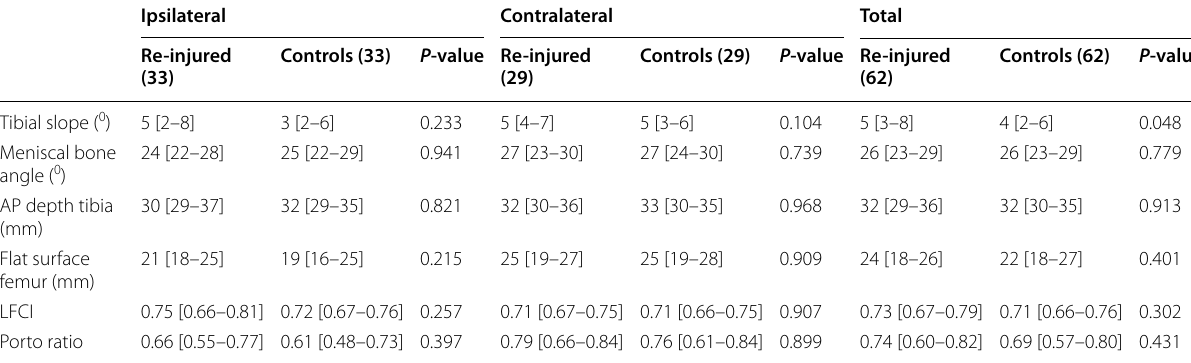
AP Anterior-posterior, IQR Interquartile range, LFCI Lateral femoral condyle index, mm Millimetres, MRI Magnetic resonance imaging